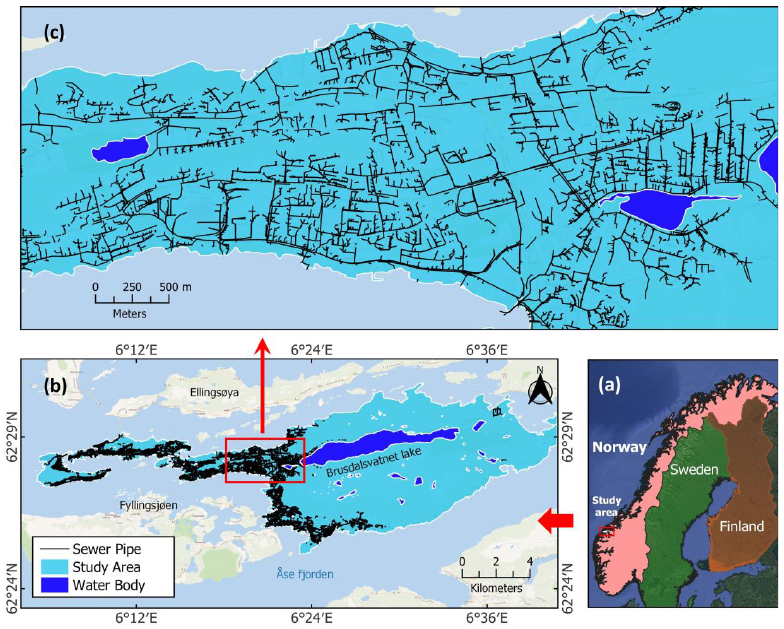
Figure 1. Location of the study area and sewer network (( a ) Location of Ålesund in Norway, ( b ) entire sewer network in Ålesund city, and ( c ) sewer network in a selected area of